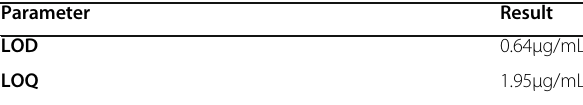
Table 15 Result of detection